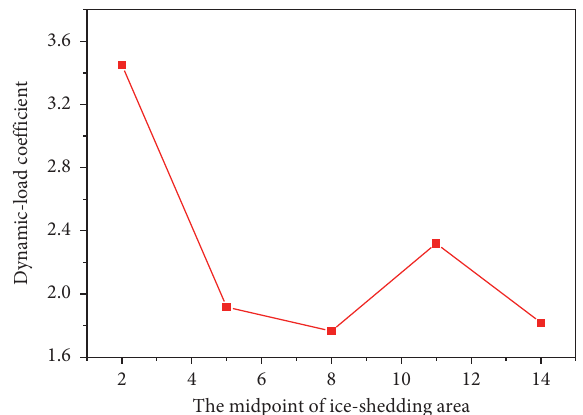
Figure 12: The variation of the dynamic-load coefficient with the midpoint of ice-shedding